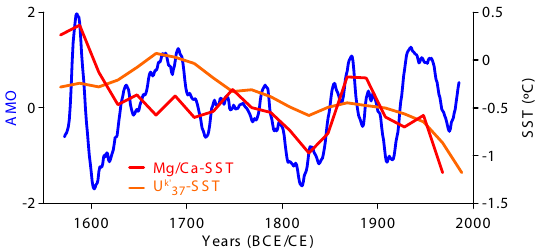
Figure 8. δ 18 O sw Minorca stack (‰ SMOW) during the last mil- lennium (age is expressed in years CE) plotted with (a) NAO re- construction (Ortega et al., 2015) and (b) palaeostorm activity in the Gulf of Lion (Sabatier et al., 2012). Notice that the NAO axis is on a descending scale. Grey vertical bars represent negative NAO phases.